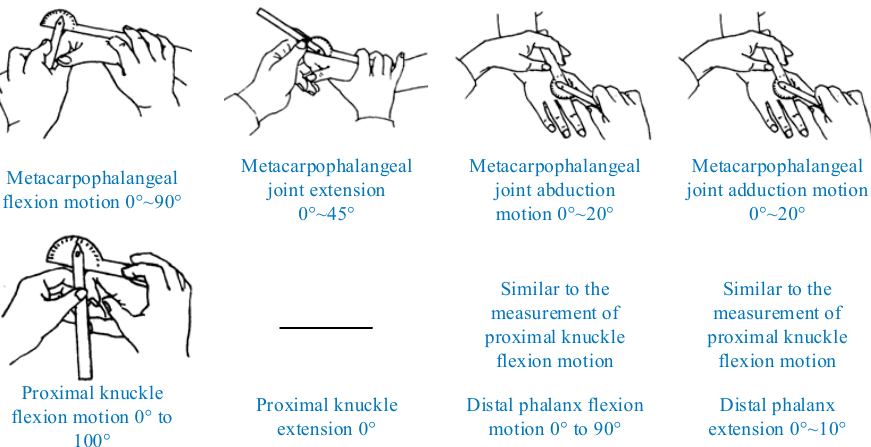
Figure 2. Human finger-joint range of motion and measurement methods.